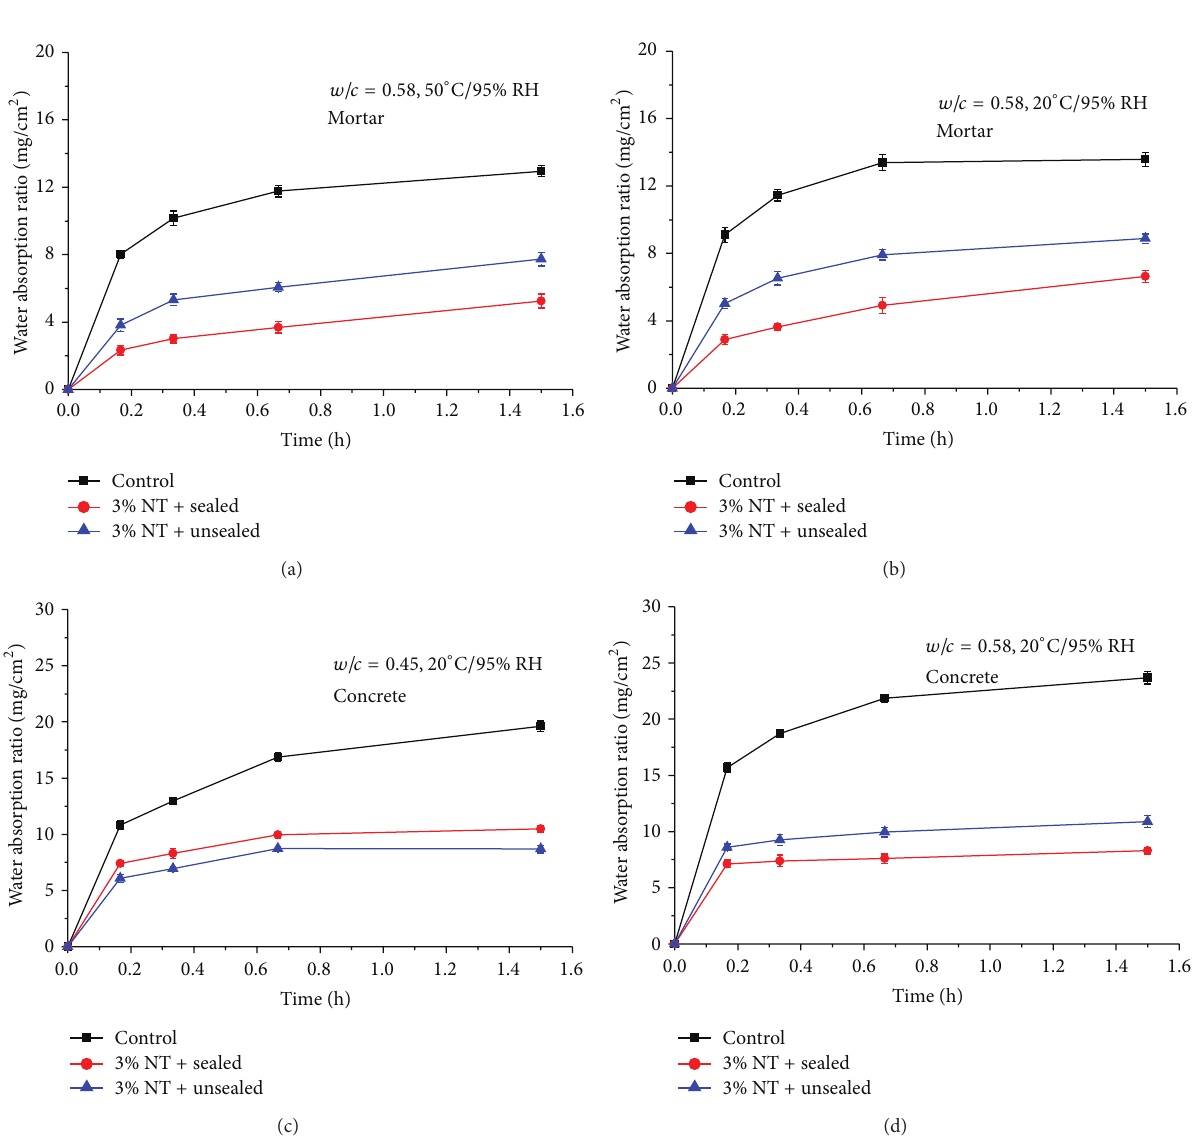
Figure 7: Influence of NT on the water absorption of hardened mortars and concretes at 28